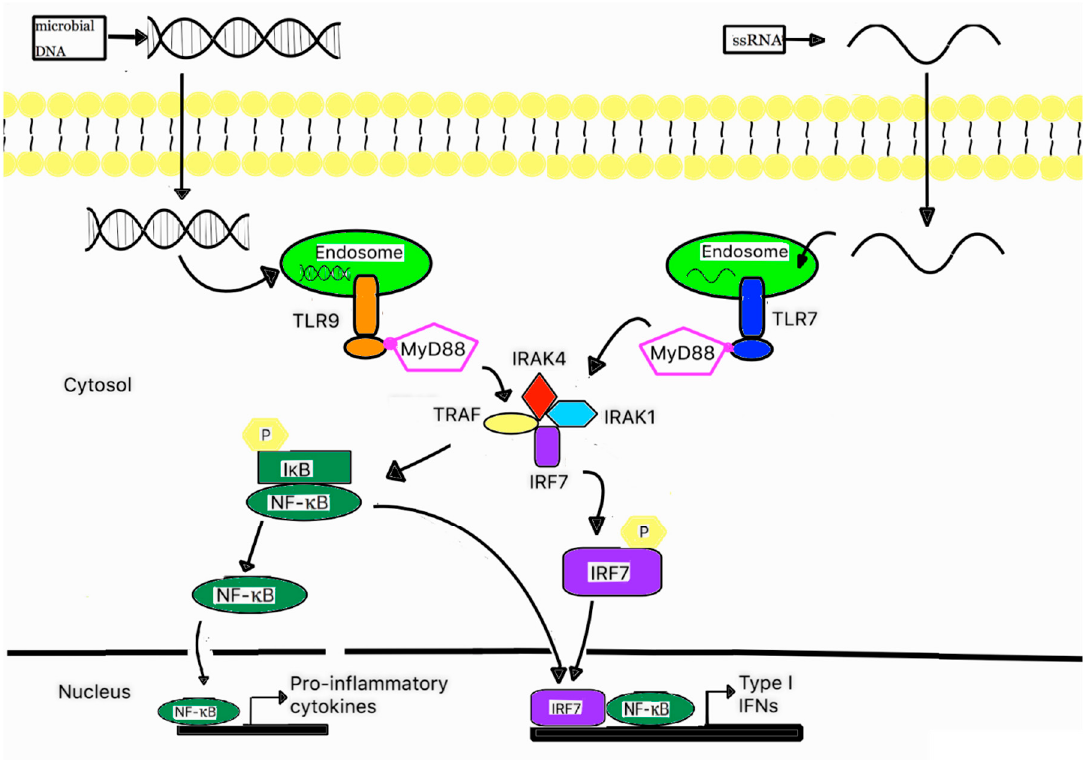
Figure 2. A schematic signaling pathway of TLR7 and 9. Plasmacytoid dendritic cells abundantly express TLR7 and TLR9 on their endosomal membranes, TLR7 and TLR9 are responsible for recognizing ssRNA and unmethylated CpG region of DNA. Once activated, TLR7 and TLR9 recruit adaptor protein MyD88, which subsequently forms a complex with IRAK4, TRAF6, IRAK1, and IRAF7. This complex can activate NF-kB and phosphorylate IRF7. Then, the activated NF-kB and phosphorylated IRF7 are translocated into the nucleus, where they induce the gene expression of pro-inflammatory cytokines and type I IFNs.